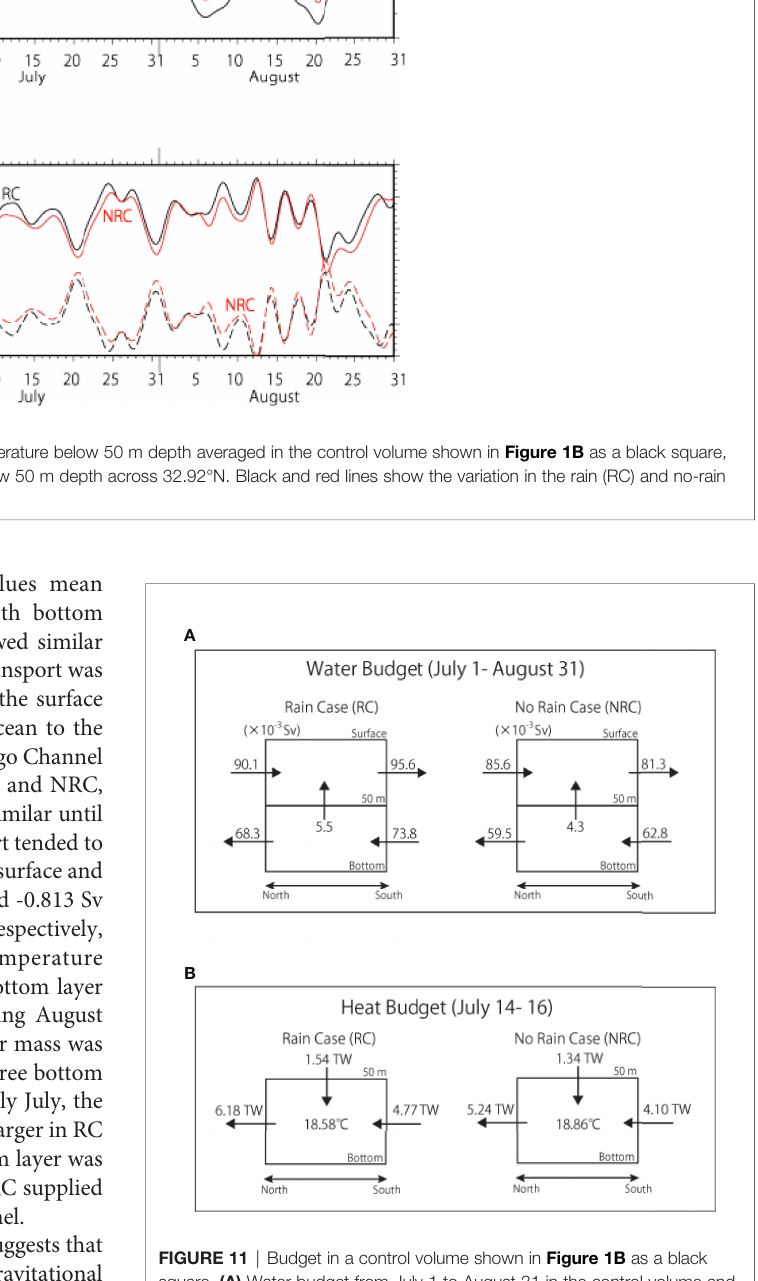
FIGURE 11 | Budget in a control volume shown in Figure 1B as a black square. (A) Water budget from July 1 to August 31 in the control volume and numbers indicate volume transport. Unit is in 10 -3 Sv. (B) Heat budget below 50 m depth in the control volume from July 14 to 16 and numbers on the arrows indicate heat transport with a unit in TW. Numbers in the boxes show average water temperature below 50 m depth from July 14 to